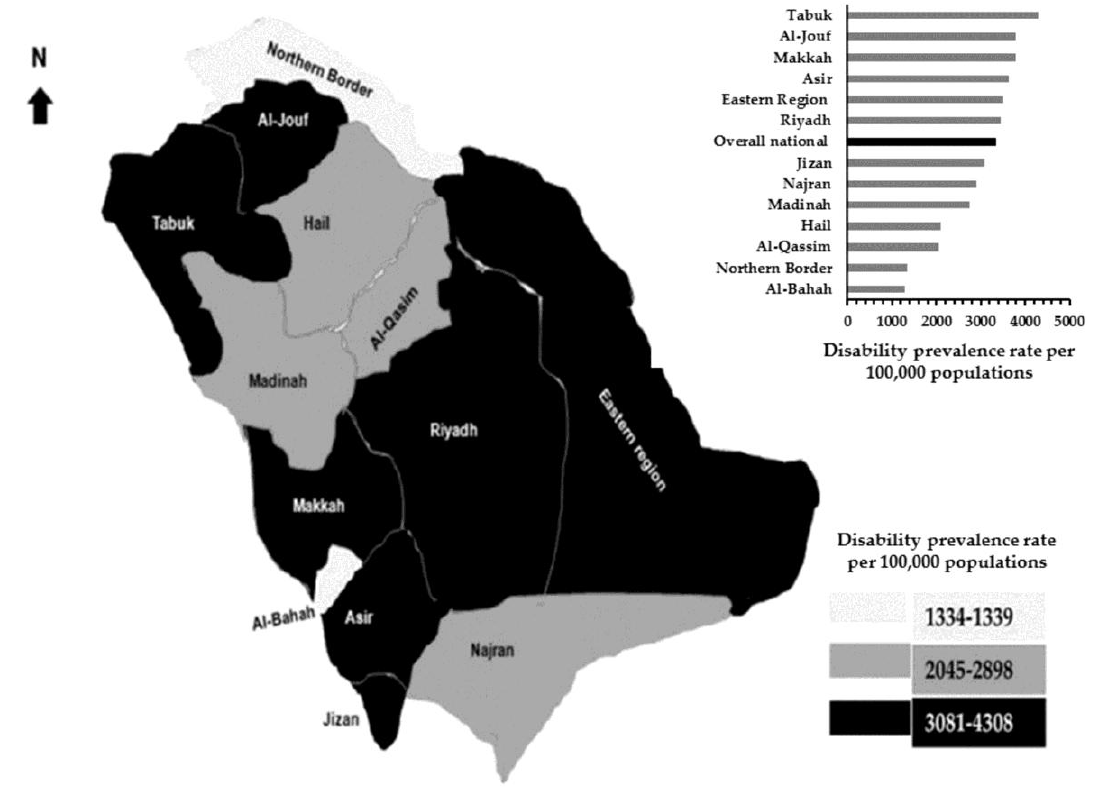
Figure 2. The national and regional disability prevalence rates per 100,000 populations in 2016.